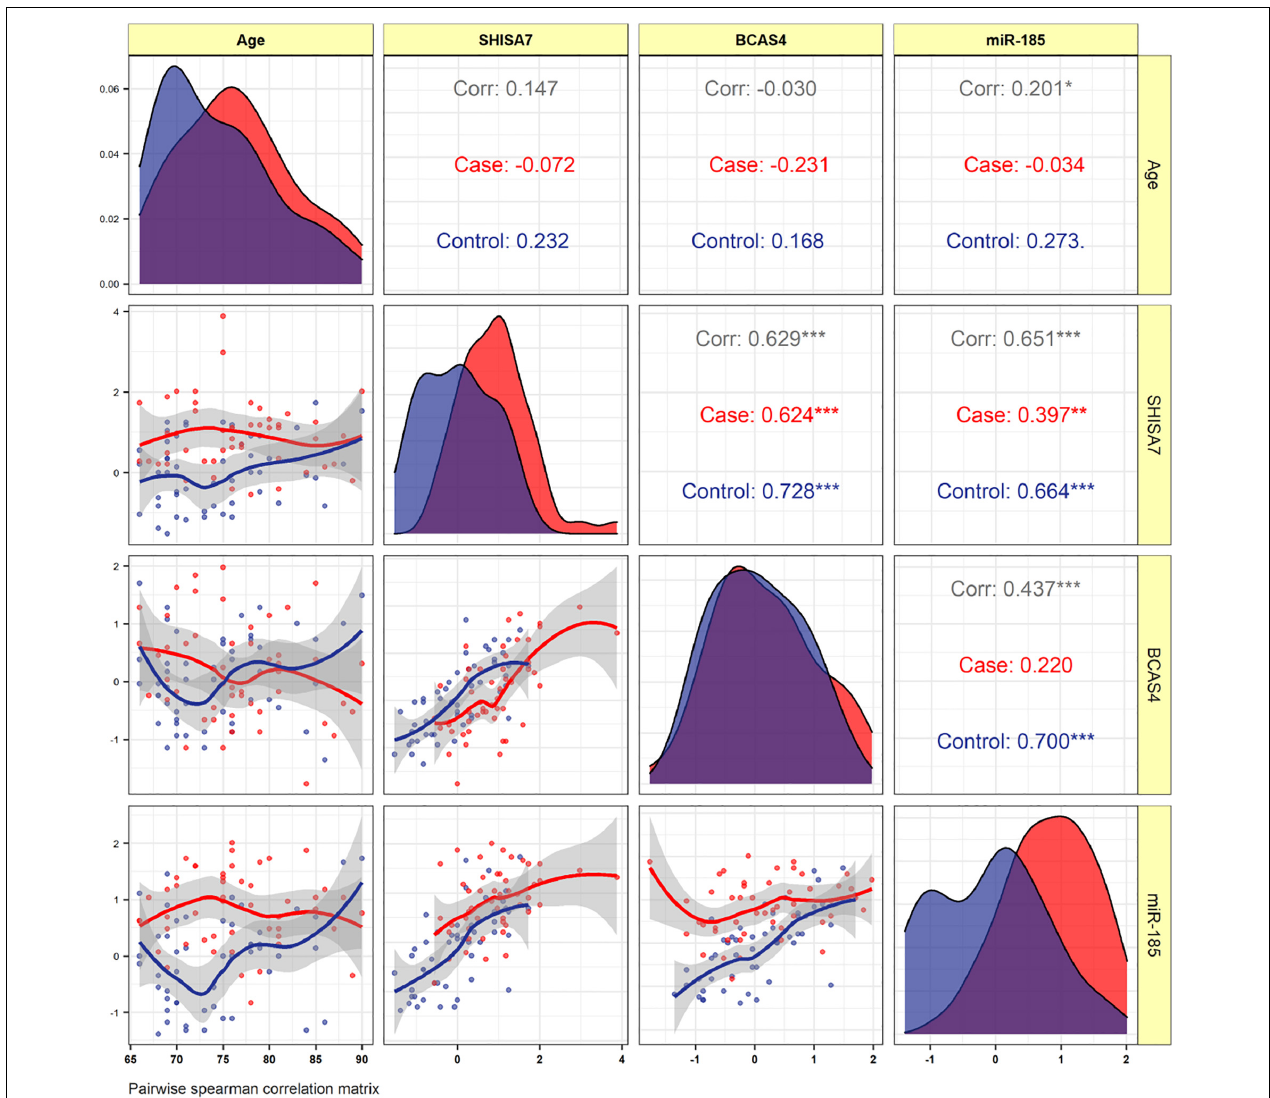
FIGURE 5 | The distribution of variables is depicted on the diagonal. The correlation coefficients plus the significance level as stars are shown. *, **, and *** is significant correlation at P < 0.05, P < 0.01, and P < 0.001,